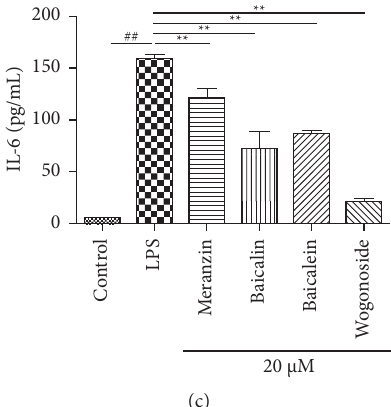
Figure 9: Effects of meranzin, baicalin, baicalein, and wogonoside on the production of TNF- α , IL-4, and IL-6 in lipopolysaccharide- (LPS-) stimulated RAW264.7 cells. The model group was treated with a basal medium for 2h and then stimulated with 1 µ g/mL LPS for 24h. Results are expressed as mean ± SD from three independent experiments ( n � 3). ## P < 0 . 01, compared with the control group; ∗∗ P < 0 . 01, compared with the LPS-treated group.